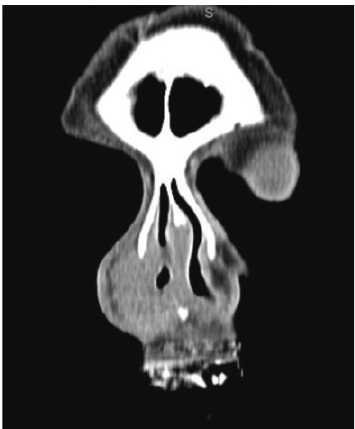
Figure 3: Axial MRI T2 FLAIR image of the nasal lesion with relatively homogeneous, low intensity signal.